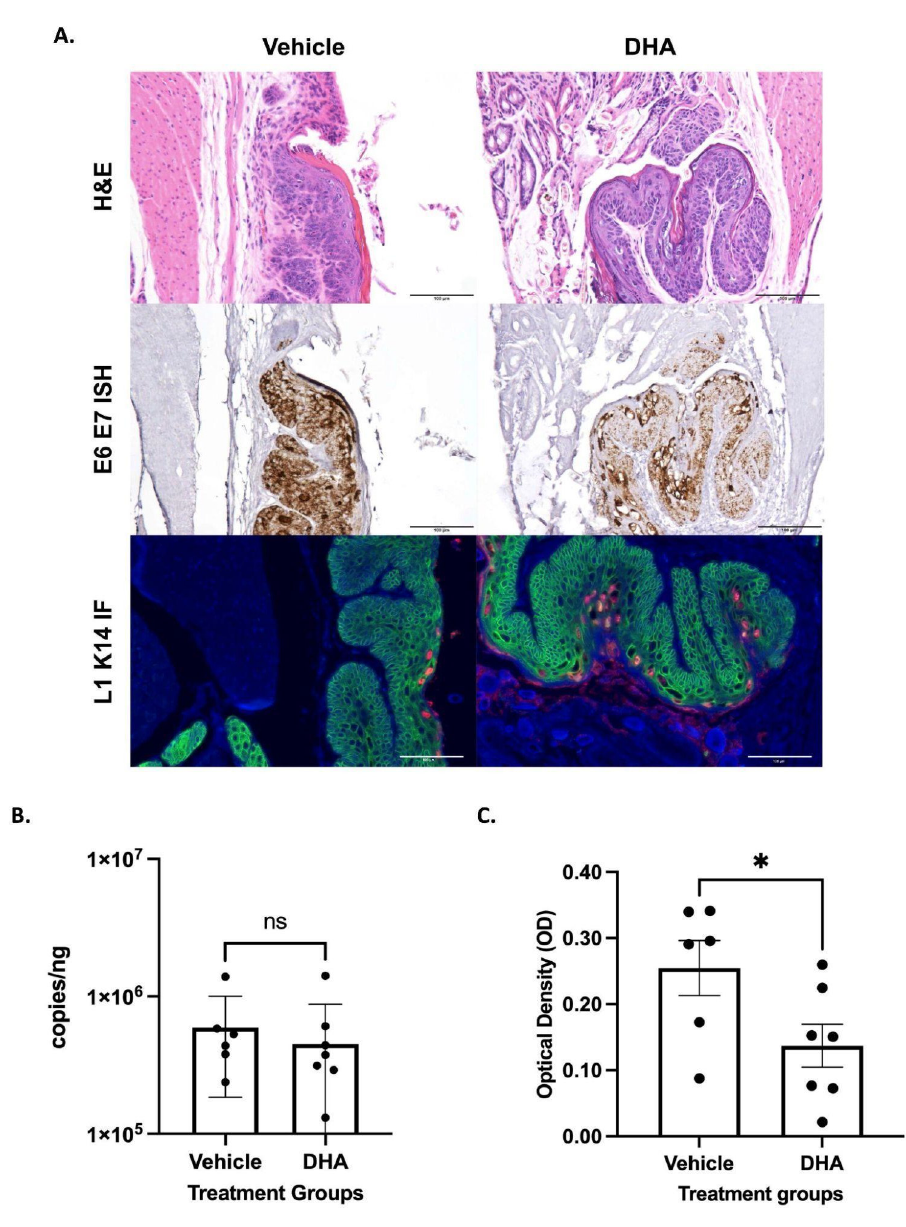
RNA between vehicle-treated and DHA-treated NSG mice based on RNAscope analysis ( p = 0.7144) (Figure 3A,C).